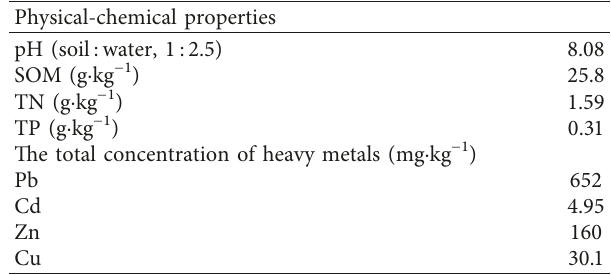
Table 1: Soil physical-chemical properties and heavy metals